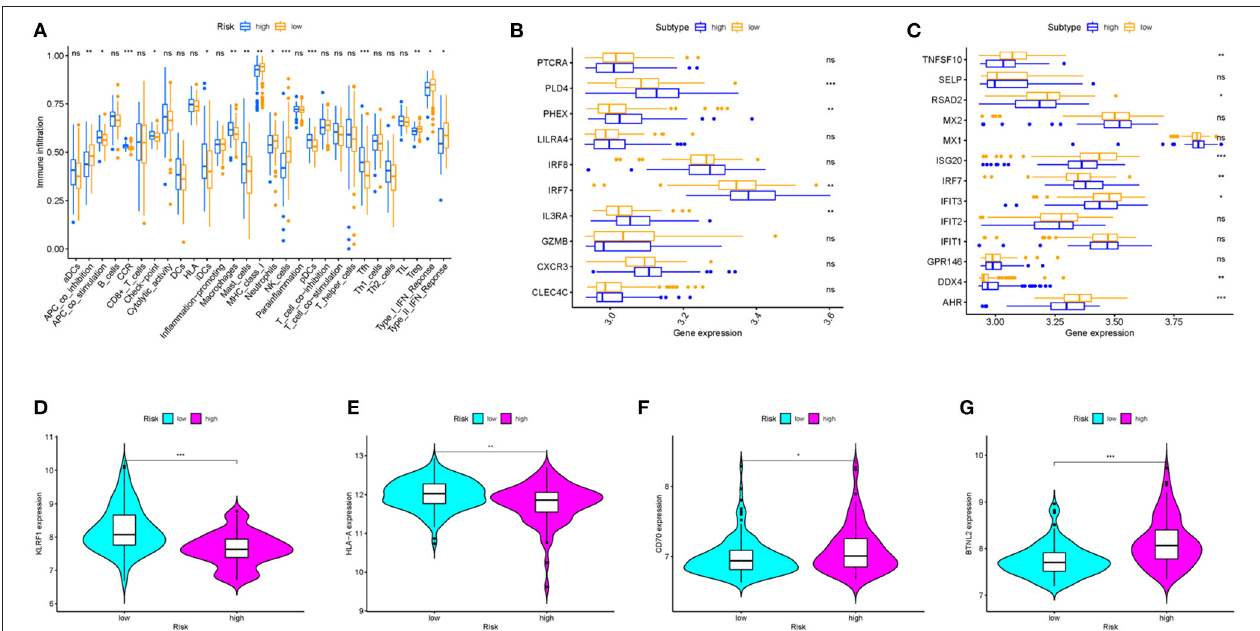
FIGURE 5 | The relationship between prognostic signature, immune cell infiltration, and immune functionality. (A) The relative enrichment of 29 immune-related risk terms in high- and low-risk HCV-related early-stage cirrhosis patients. (B) pDCs family genes and (C) type I and type II IFN response family genes expression profiles in high and low-risk groups. (D–G) KLRF1, HLA-A, CD70, and BTNL2 expression levels in different groups.